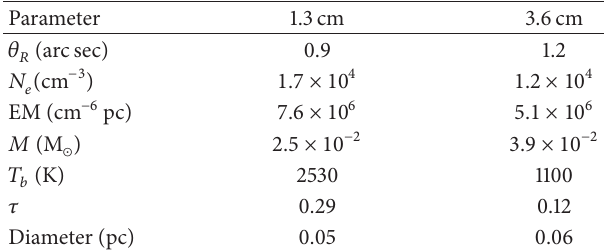
Table 2: Physical parameters obtained for the cometary H ii region G75.78+0.34 from the 1.3cm and 3.6 cm images.